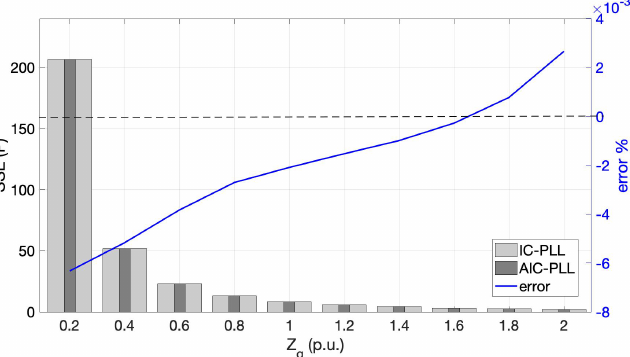
Figure 16. SSE for the active power tracking for the IC-PLL- and AIC-PLL-based system for the maximum power (inverter operation).